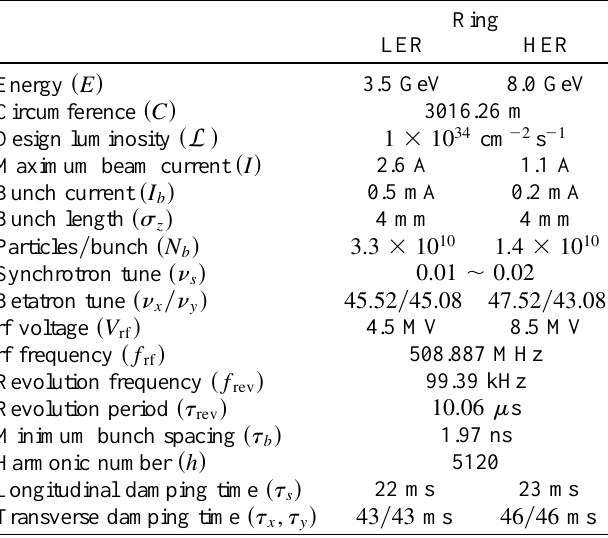
TABLE I. Main parameters of